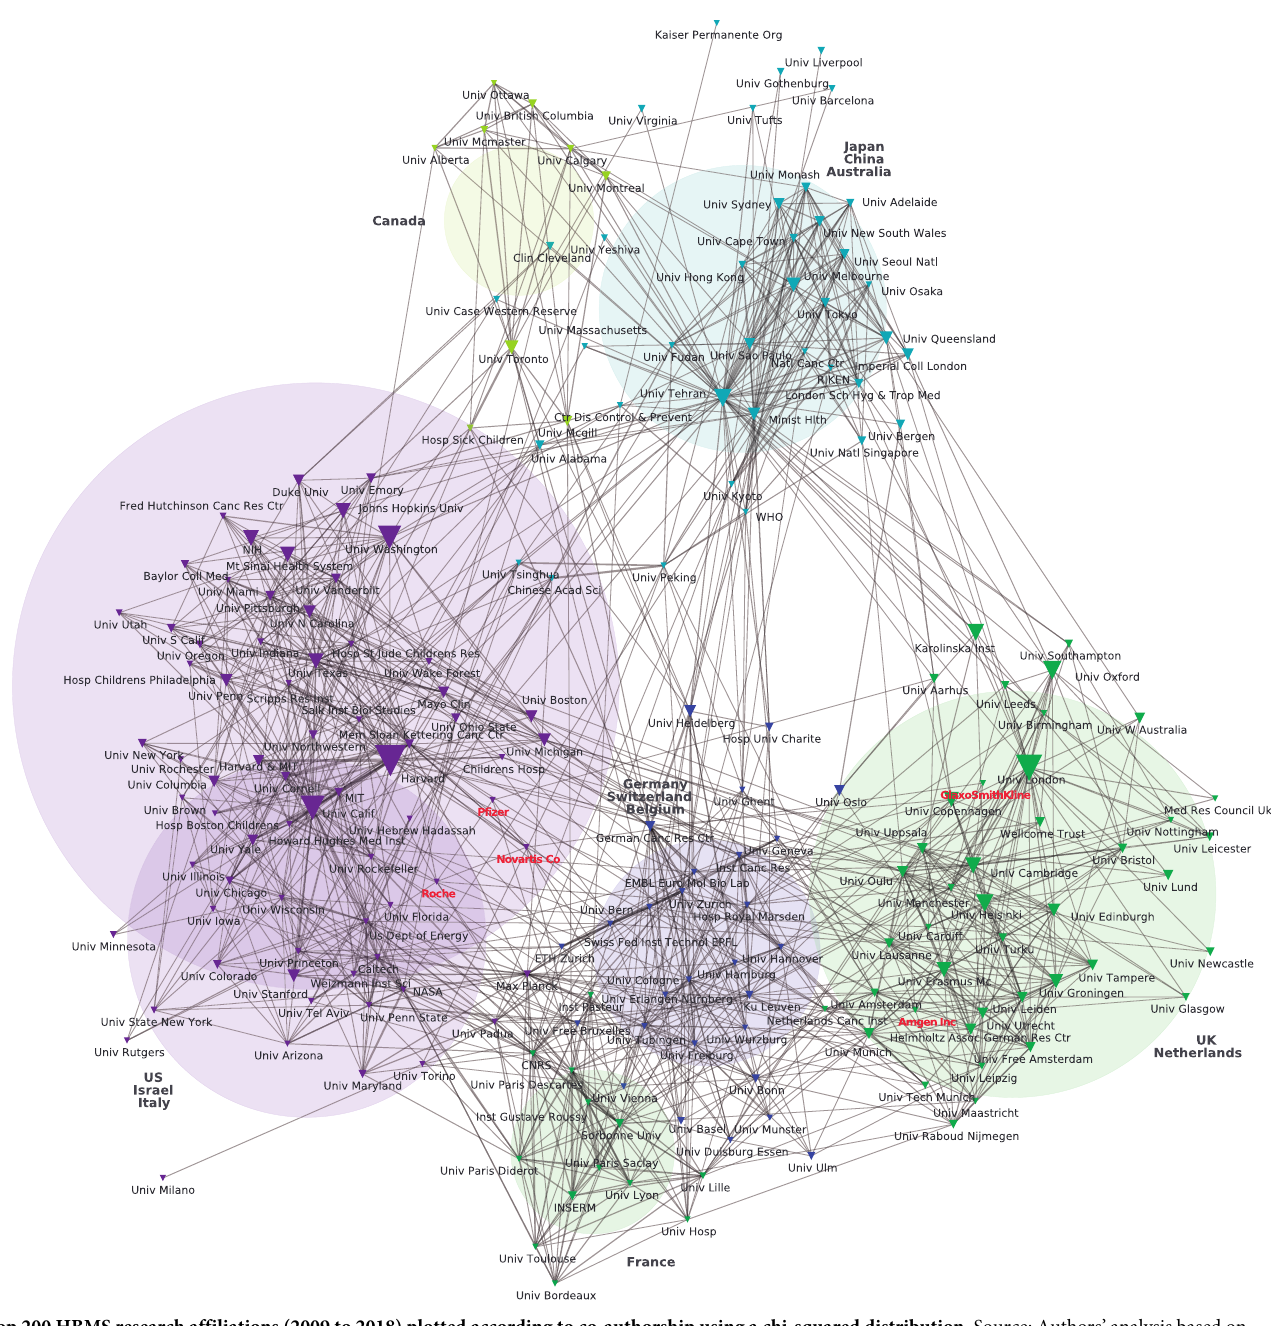
Fig 2. Top 200 HBMS research affiliations (2009 to 2018) plotted according to co-authorship using a chi-squared distribution. Source: Authors’ analysis based on WoS data extraction plotted via CorTexT.